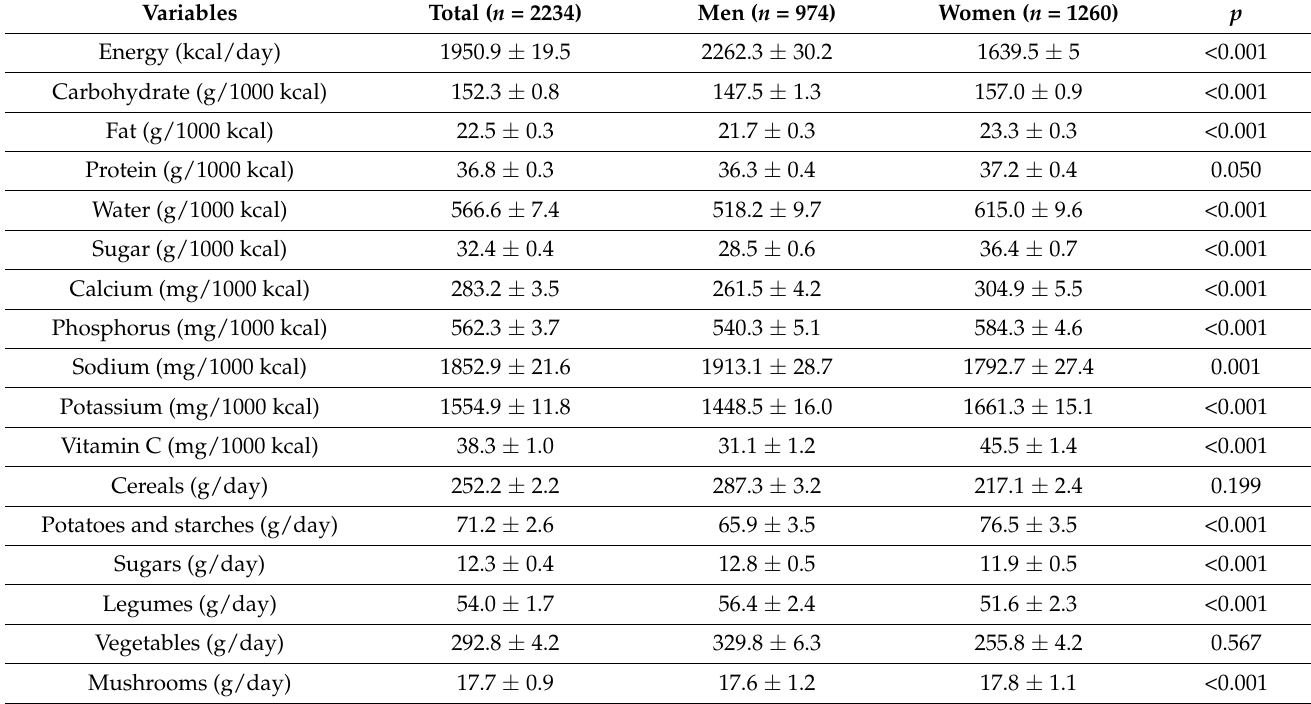
Table 1. Nutrients and food intake characteristics of participants according to